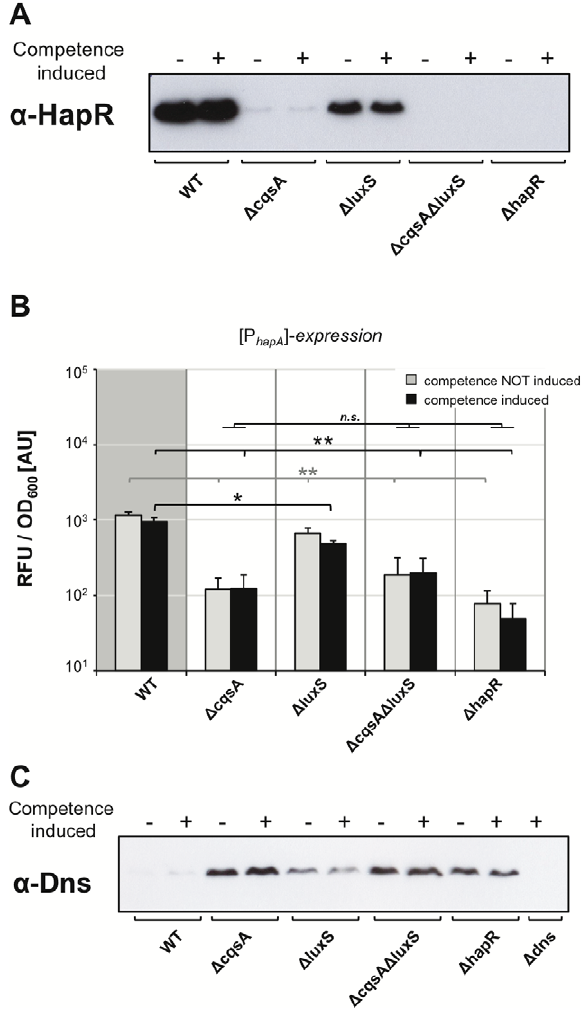
Figure 5. Correlation among HapR protein levels, hapA gene expression, and the nuclease Dns. Panel A and C: Proteins of the indicated strains, each containing artificially inducible tfoX on the chromosome, were separated by SDS-PAGE. After blotting, the relative abundance of proteins HapR (panel A) or Dns (panel C) were determined by detection with protein-specific antibodies. For each sample 6 m g (panel A) and 12 m g total protein (panel C), respectively, were applied per lane. Strains were tested under non-competence- inducing and competence-inducing conditions as indicated above each image. Panel B: HapR-dependent expression of hapA promoter-driven gene expression was quantified as described in Figure 3 for comEA / pilA . The growth conditions were as described for Figure 4. Averages of three independent experiments are indicated. Error bars indicate standard deviations. Statistically significant differences were calculated using the Student’s t test. * P , 0.05, ** P , 0.01, n.s. =not significant.